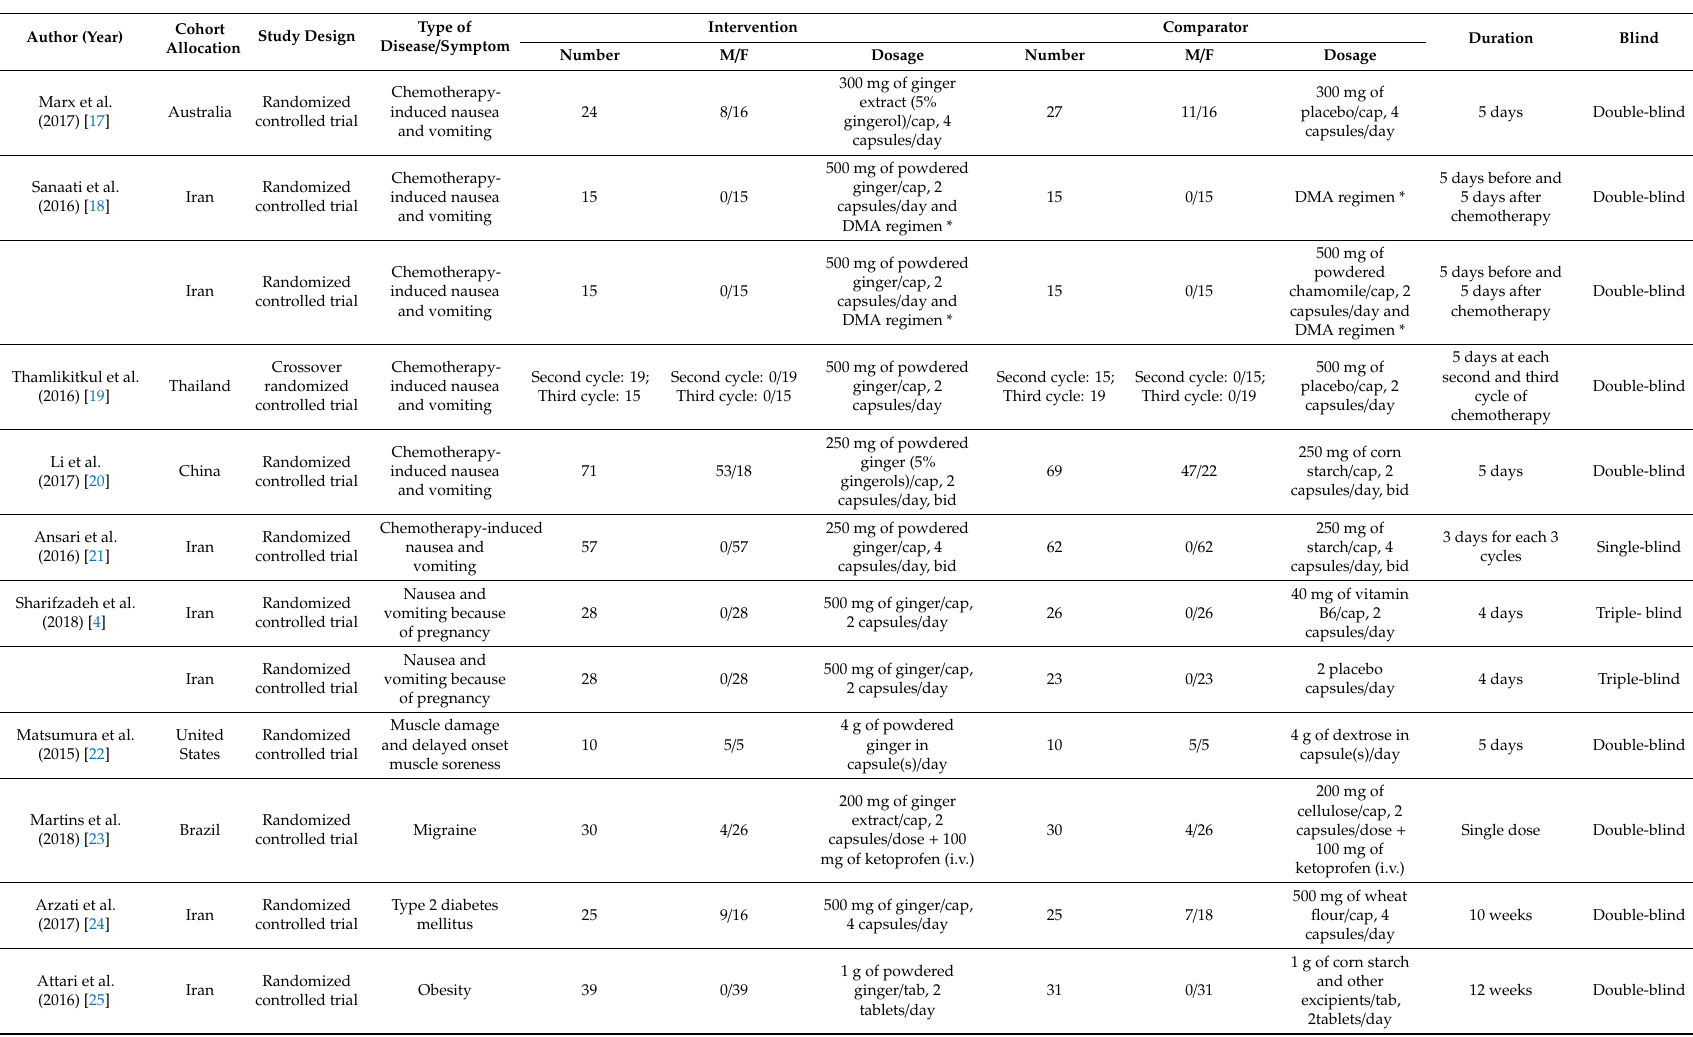
Table 1. Study design and demographic description of the included studies with a “high quality of evidence” (quality assessment score is of at least